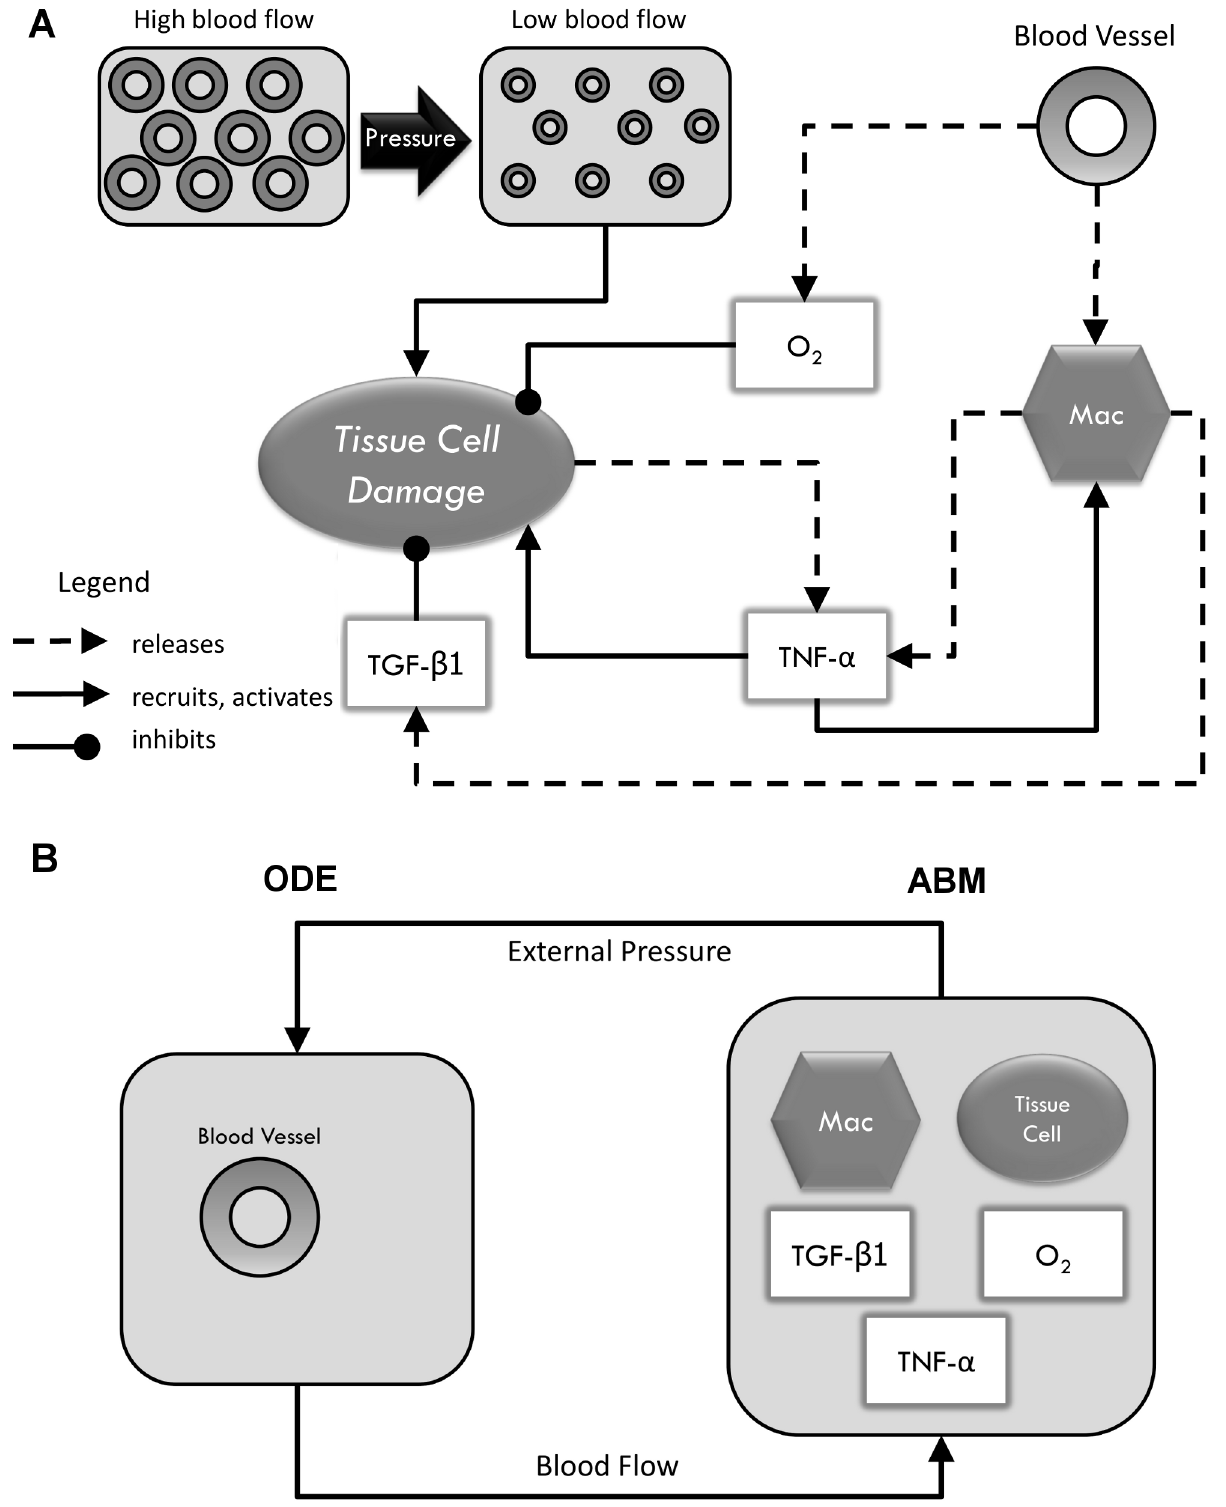
Figure 2. Components of the hybrid model of pressure ulcer formation. Panel (A) shows interactions between main components of the model. Panel (B) demonstrates the connection between ODE and ABM portions of the model. Geometric shapes represent model components. Arrows show interactions between components. ‘‘Mac’’ in the figure represents inflammatory cells (nominally macrophages).